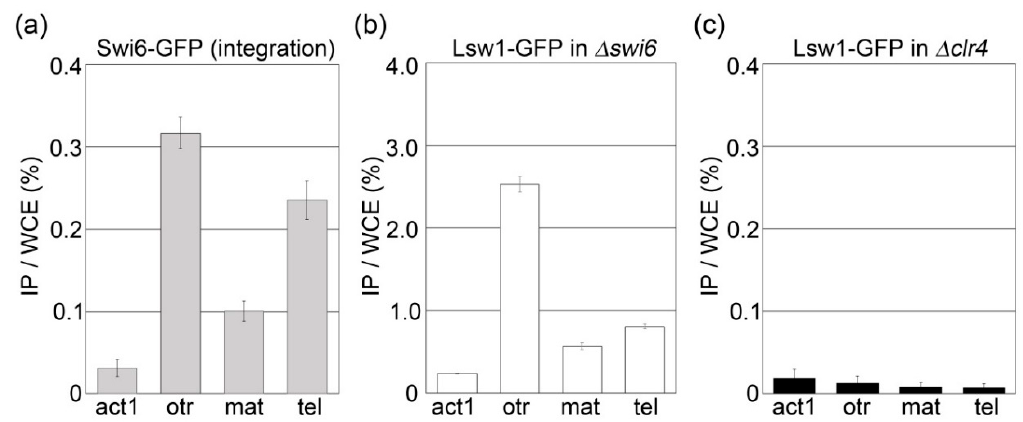
Figure 7. Lsw1 binds to fission yeast heterochromatin regions. Cell lysates were prepared from Swi6-GFP (YTP1889, ( a )), ∆ swi6 (YTP1847, ( b )) or ∆ clr4 (YTP1901, ( c )) containing pGP4110-Lsw1. DNA co-immunoprecipitated with anti-GFP antibody was quantified by real-time PCR analysis of the outer centromere ( otr ) region, mating type locus (mat), or subtelomere (tel). act1 was used as a negative control. The amount of immunoprecipitated DNA was calculated as a percentage of whole-cell extract (WCE). The error bars indicate the standard deviation from three or four independent experiments.